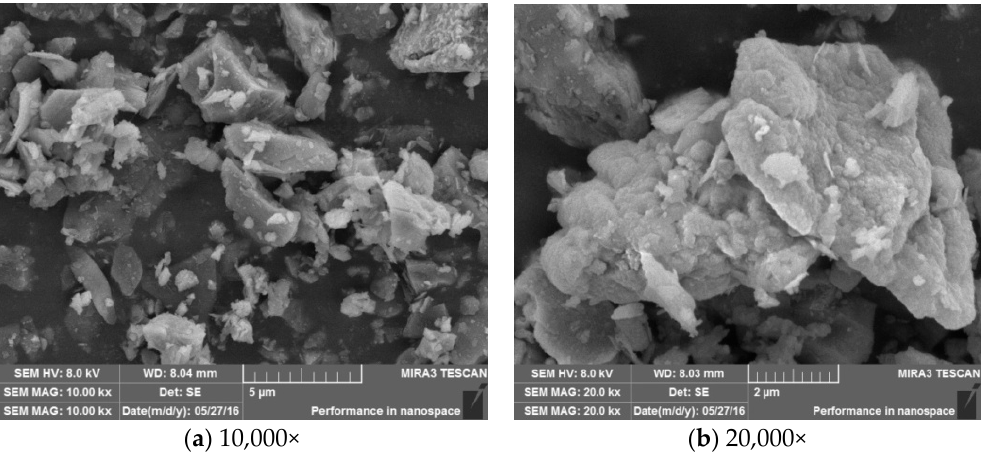
Figure 12. SEM images of the sample TM11 (Table 3) (10,000 ( a ) and 20,000 ( b ) magnification).